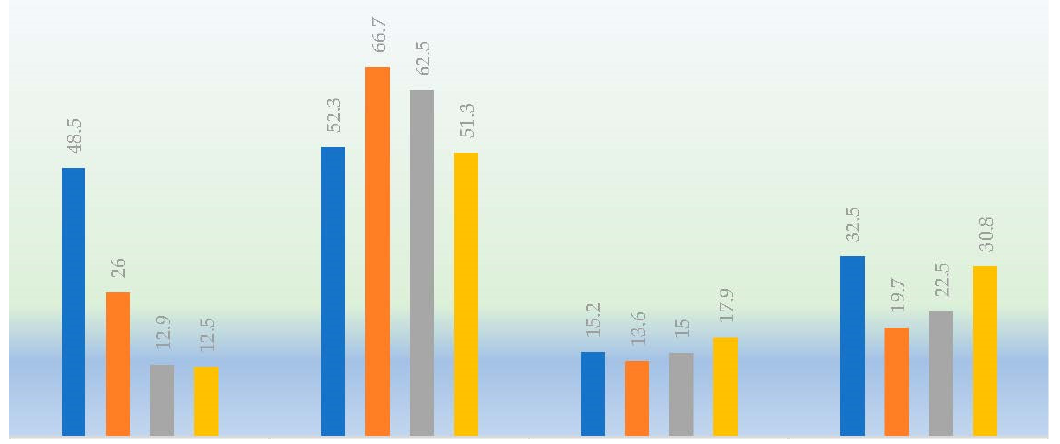
Figure 1. Reasons for the acceptance towards the vaccines against the COVID-19 disease in students of the three degrees.